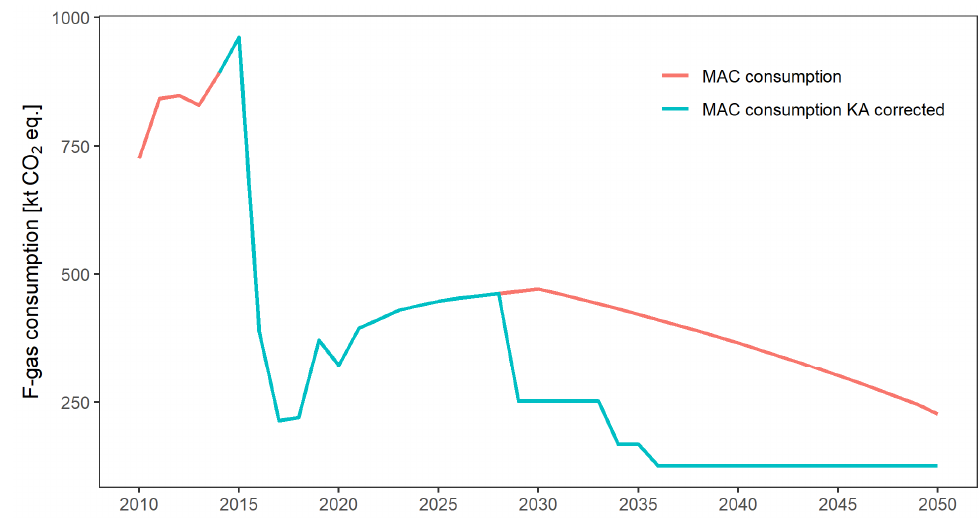
Figure 2. MAC F-gas consumption in the years 2010–2050 with and without the KA correction.